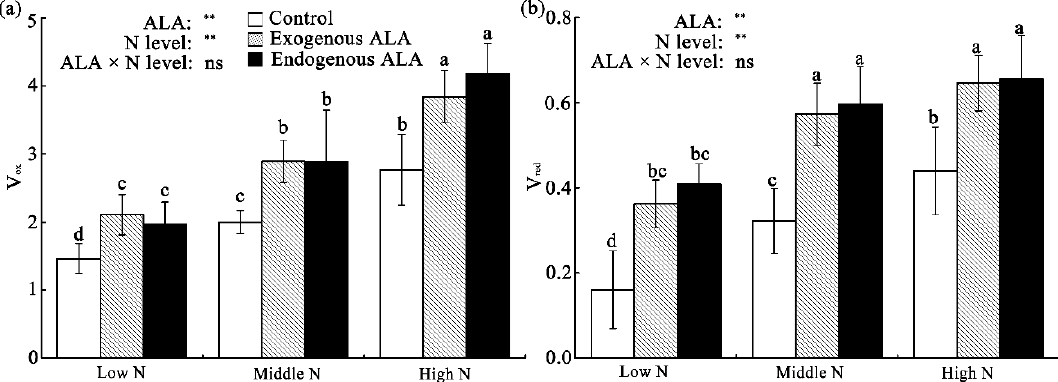
Figure 6. Changes in the velocities of ( a ) P700 and plastocyanin (PC) oxidation (V ox ) and ( b ) subsequent rereduction (V red ) in exogenously-treated and endogenous ALA-overproducing canola leaves grown under low-, middle-, and high-N conditions. Values are means ± standard error ( n = 10). The same letter indicates a nonsignificant difference ( p > 0.05), according to Duncan’s test. Source of variation: ALA, N-level, and ALA × N-level interaction; ** p < 0.01; ns: not significant.